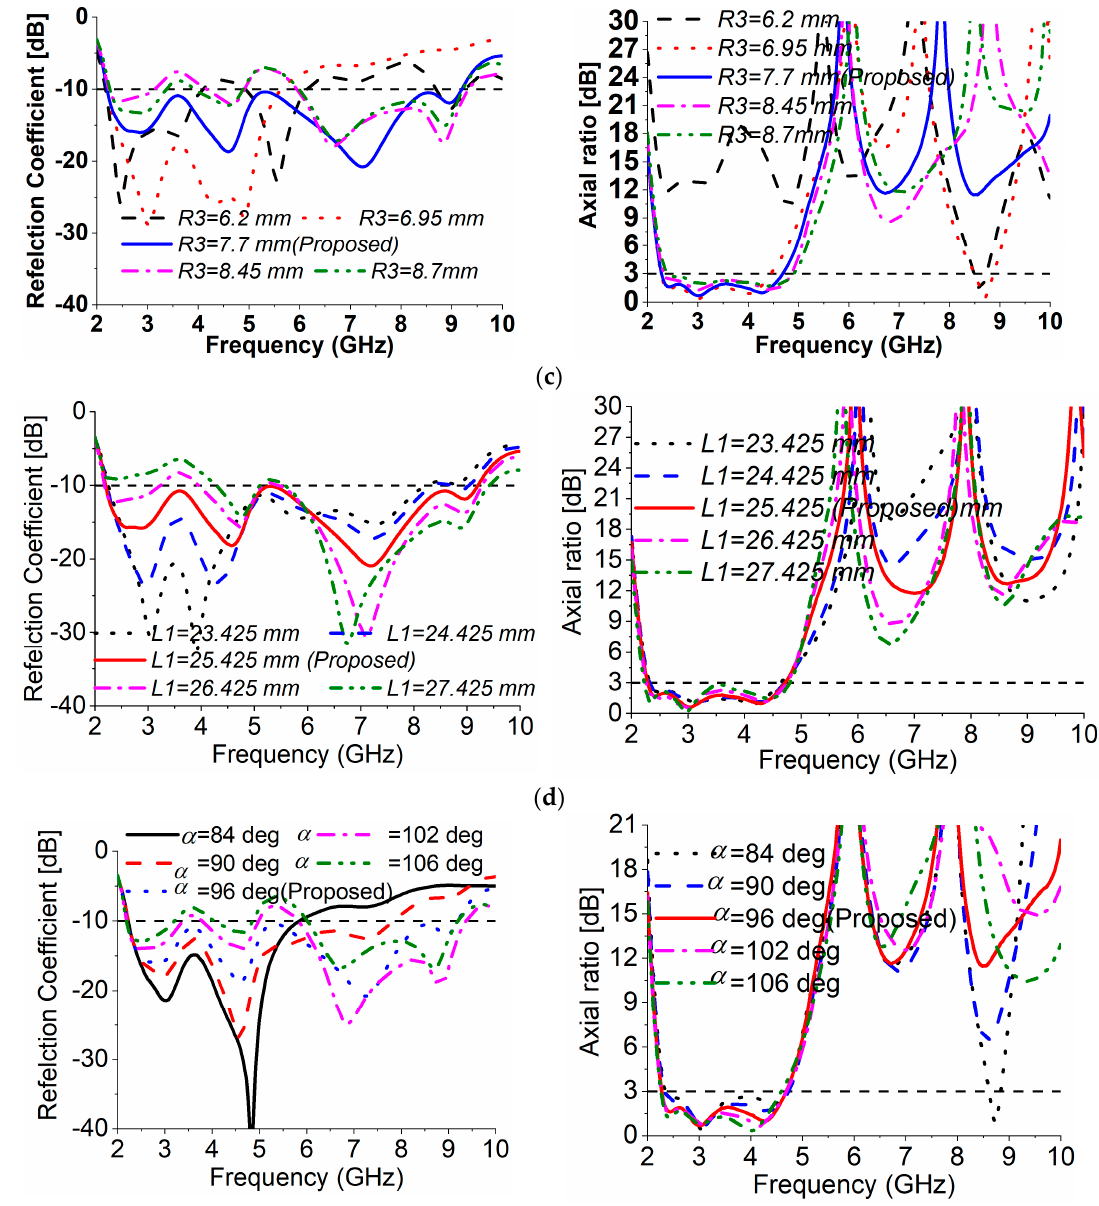
Figure 5. Numerical S 11 and AR performance with different values of ( a ) R1 , ( b ) R2 , ( c ) R3 , ( d ) L1 , ( e ) α .